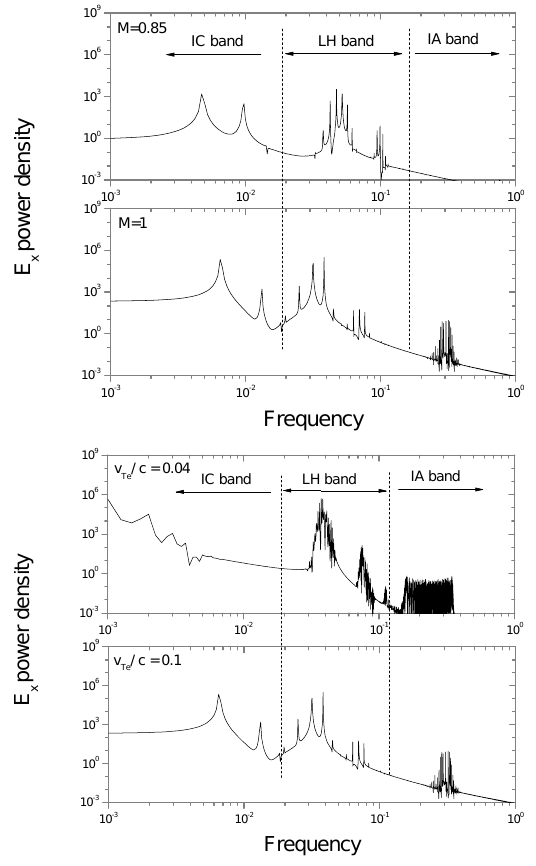
Fig. 17. FFT power spectra of E x under two input parameters M = 0 . 85 and 1 in Fig. 13 (left panels) and V T in Fig. 16, respectively, as two examples to illustrate the the varia- tion of frequency with input parameters as exposed from Figs. 13 to 16. The different bands (IC/LH/IA) are labeled in all panels.